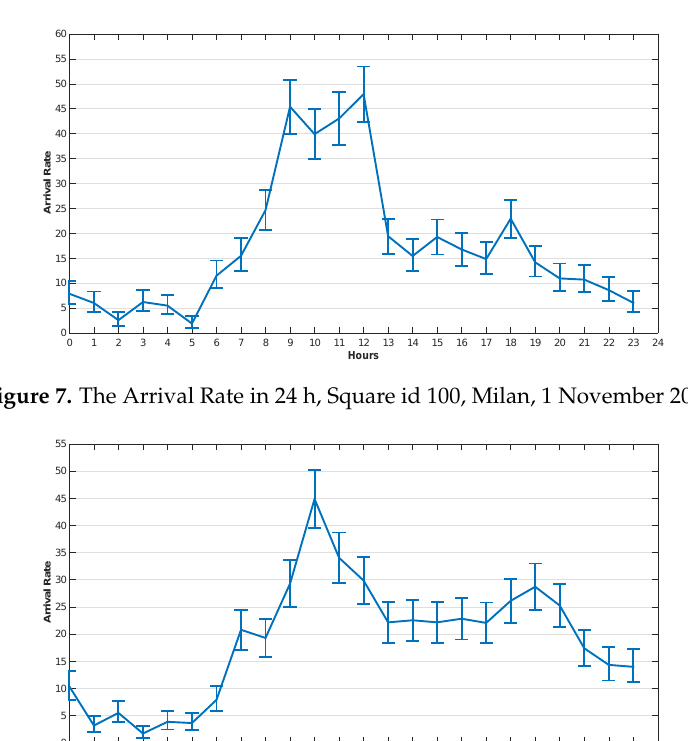
Figure 6. The Arrival Rate in 24 h, Square id 1, Milan, 1 November 2013.